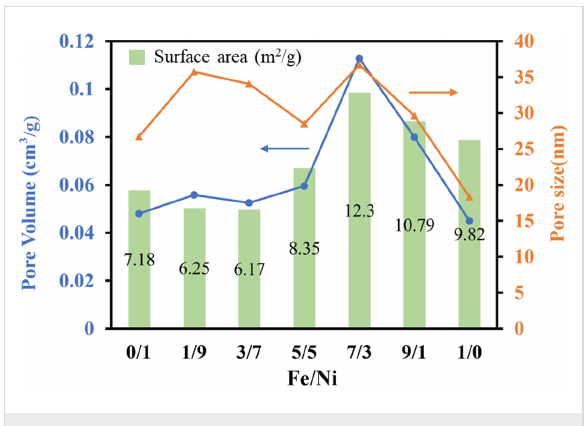
Figure 6: Specific surface area, pore size, and pore volume of the samples with different Fe/Ni ratios.